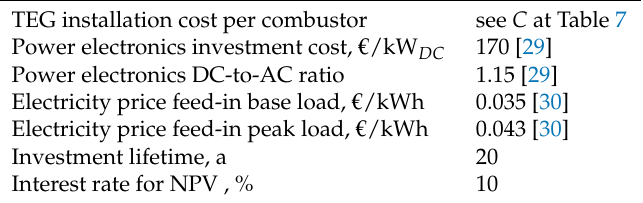
Table 9. Basic assumptions for the economic evaluation of TEGs.